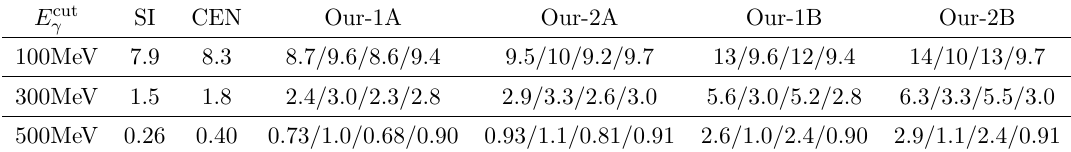
Table 1 . Branching ratios of the τ − → π − π 0 γν τ by taking different photon energy cuts E cut the entries in each column (except the first one) are multiplied by 10 − 4 . The results in the columns labeled by SI and CEN are obtained by taking the structure independent expressions and the full amplitudes from ref. [15], respectively. The tiny differences between the numbers of ref. [15] and ours are caused by using the updated physical constants, especially the pion decay constant F π